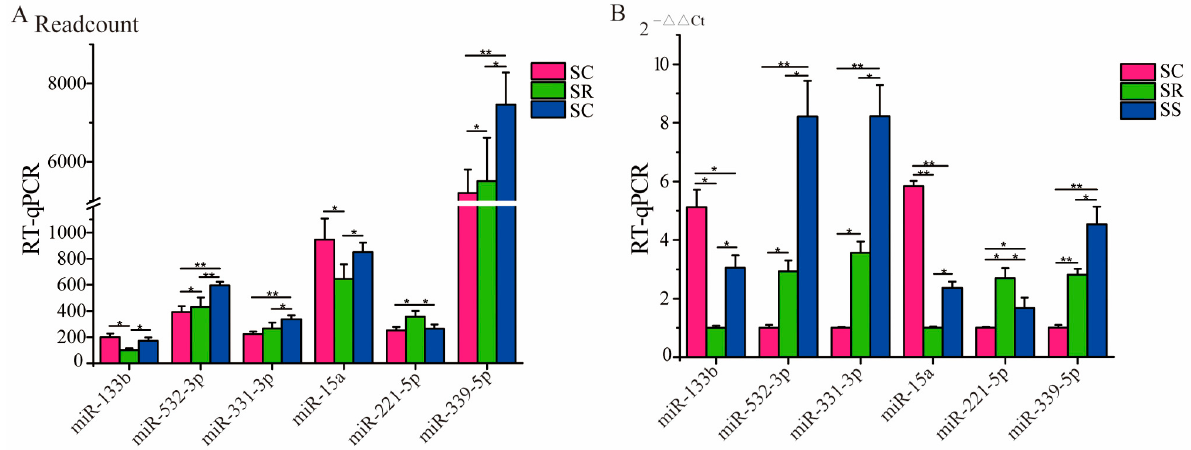
Figure 5. Validation for the RNA sequencing data by qRT-PCR. ( A ) RNA-seq results; ( B ) qRT-PCR results. The results are presented as the mean ± SE. An asterisk denotes a significant difference (* p < 0.05; ** p < 0.01).